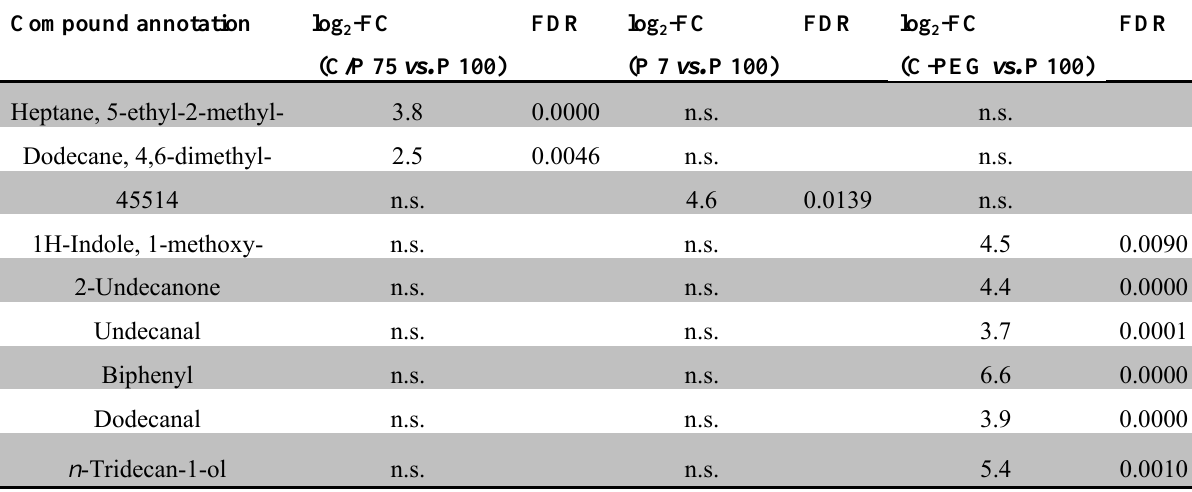
Significant, false discovery rate (FDR) of <0.05. Biological replicates, n = 4 per